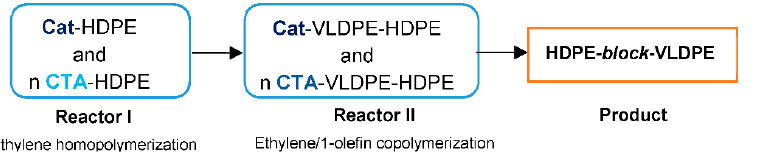
Figure 3. Synthesis of HDPE- block -VLDPE copolymer using coordinative chain transfer copolymer- ization and two reactors. Adopted from [48].